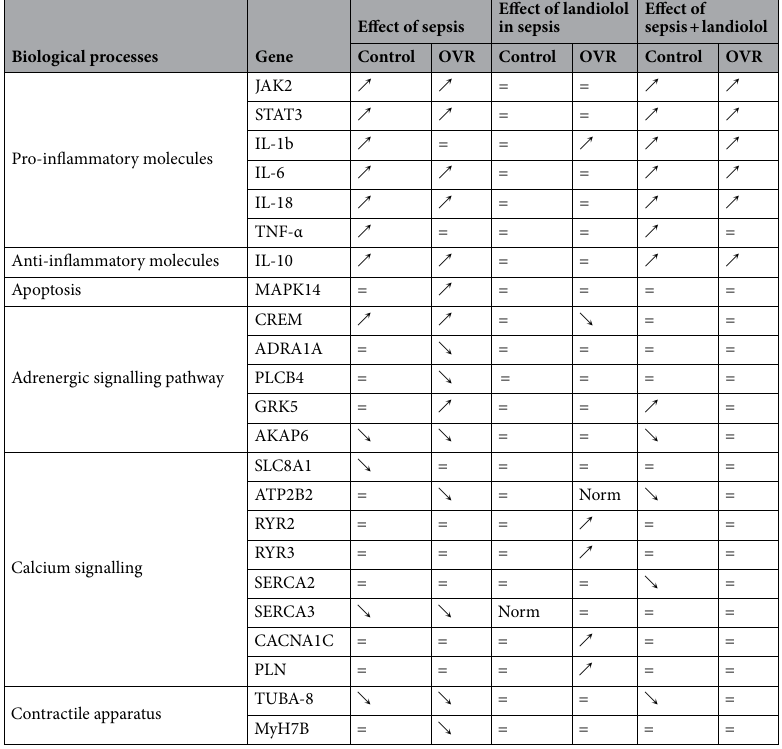
Table 3. Gene expression variation after sepsis. ↗ : upregulated; ↘ : downregulated; = : not-regulated; Norm: Normalization. Effect of sepsis: sepsis vs sham. Effect of landiolol in sepsis: sepsis + landiolol vs sepsis. Effect of sepsis + landiolol: sepsis + landiolol vs